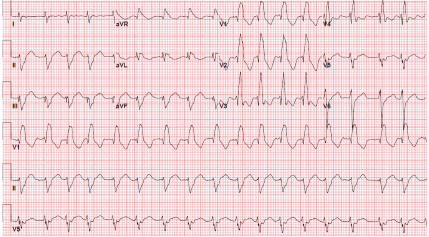
Figure 2: 12-lead electrocardiogram showing atrial fi brillation with a ventricular rate of 104 beats per minute and right bundle branch block.